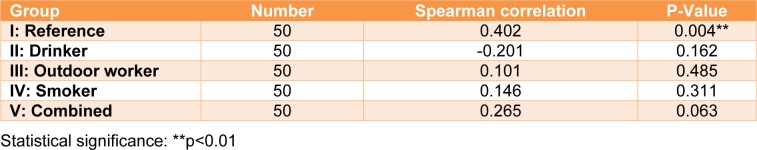
Spearman's correlation for total serum vitamin C and vitamin C dietary intake